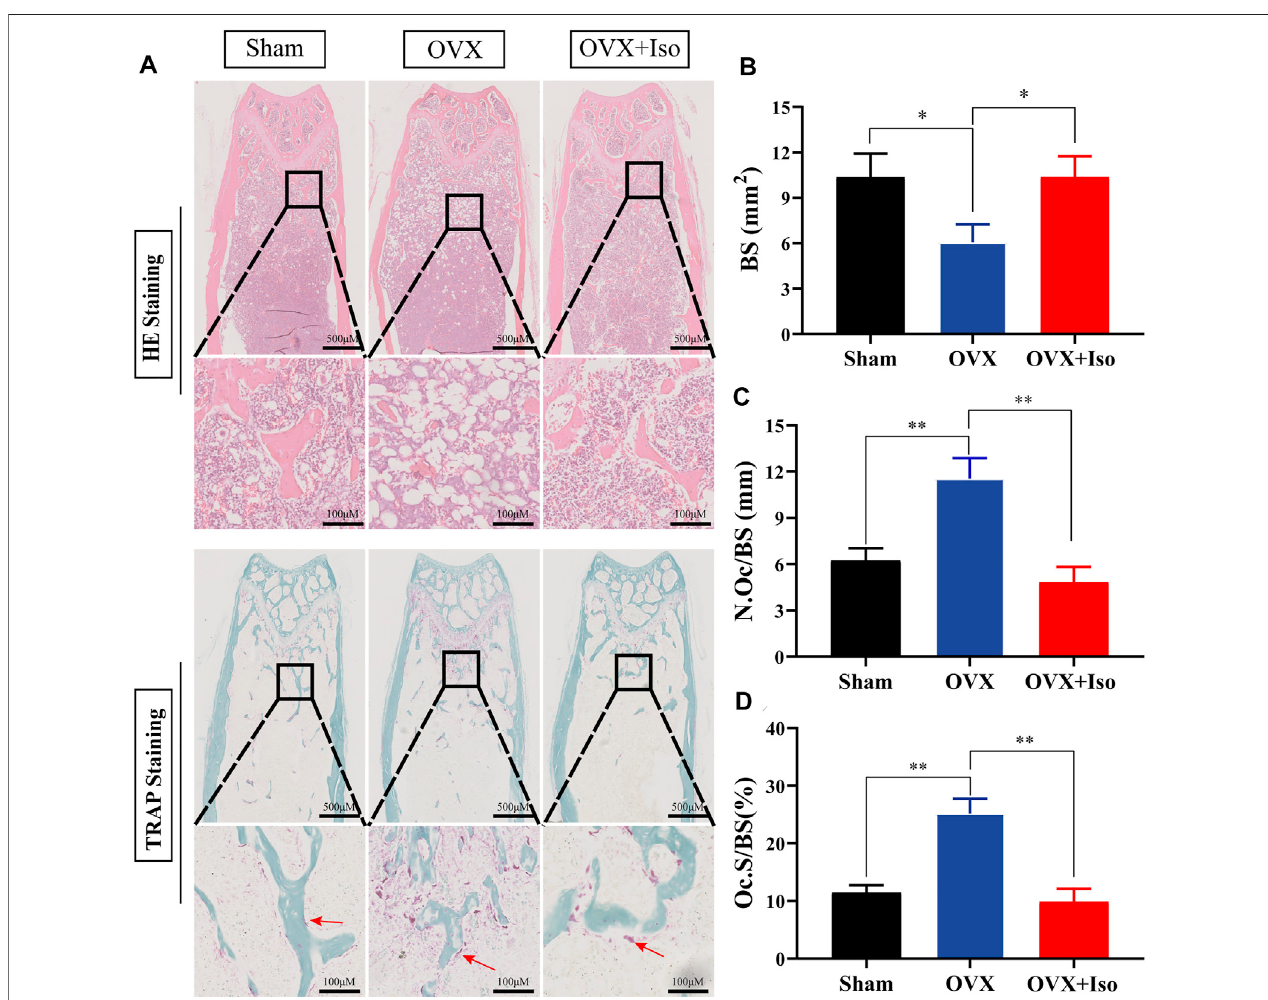
FIGURE 7 | Iso treatment reduces the production of osteoclasts in ovariectomized mice. (A) Representative photographs of H&E and TRAP staining from each treatmentgroup (B – D) Quantitativeanalysisofbonesurface(BS),osteoclastnumber/bone surface(N.Oc/BS)andosteoclastsurface/bonesurface(Oc.S/BS).Thedata are expressed as the means ± SD; * p < 0.05, ** p < 0.01, *** p < 0.001, n = 5. H&E, hematoxylin and eosin; TRAP, tartrate-resistant acid